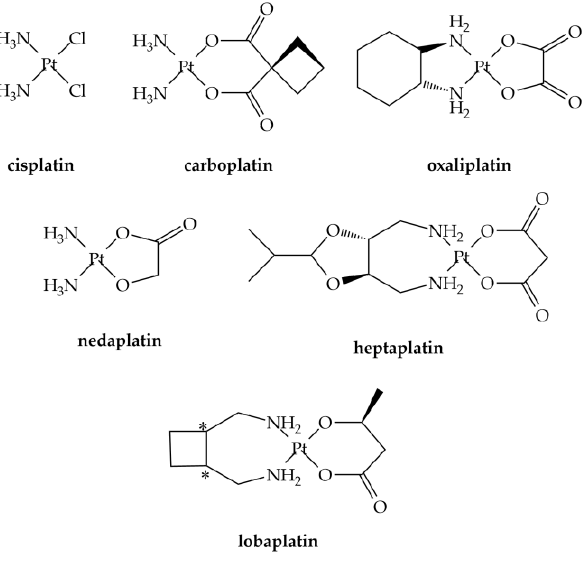
Figure 1. Clinically approved platinum anticancer drugs. *: chiral